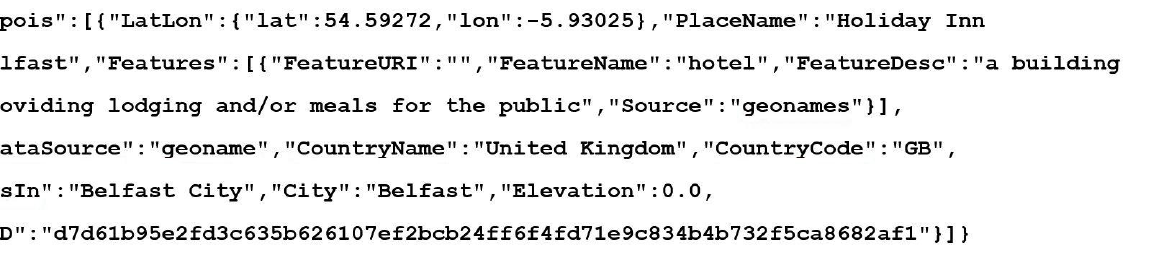
Figure 5. JavaScript Object Notation (JSON) object returned from API search